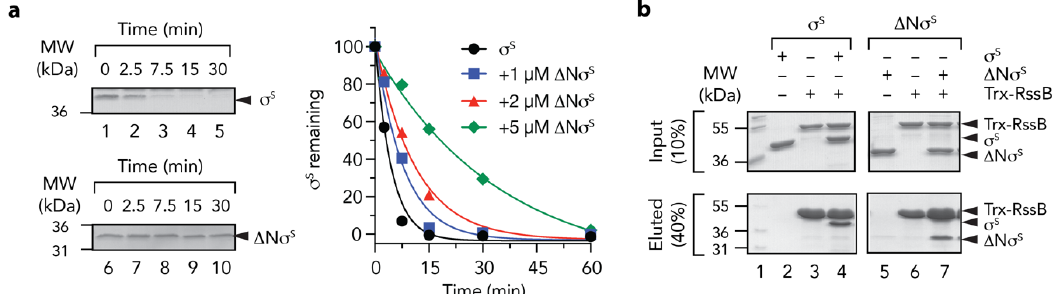
Figure 8. The N-terminus of σ s is required for delivery to ClpX(P) ( a ) The RssB-mediated turnover of σ s , by 0.6 µM ClpXP (lanes 1 – 5) is inhibited by removal of the N-terminus (residues 1 - 50) of σ s ( ∆ N σ s ) (lanes 6 – 10). Increasing concentrations of ∆ N σ s [1 µM (blue squares), 2 µM (red triangles) or 5 µM (green diamonds) inhibit the turnover of wild type σ s ]. ( b ) In vitro σ s “pull - down” experiment illustrating the interaction of wild type σ s (lanes 2 – 4) or ∆ N σ s (lanes 5 – 7) with Trx-RssB (lanes 4 and 7) in the presence of AcP. MW markers (lane 1). Proteins were separated by 15% SDS-PAGE and visualized by staining with Coomassie Brilliant Blue. The input (10%) is shown in the upper panel and the eluted proteins (40%) are shown in the lower panel.